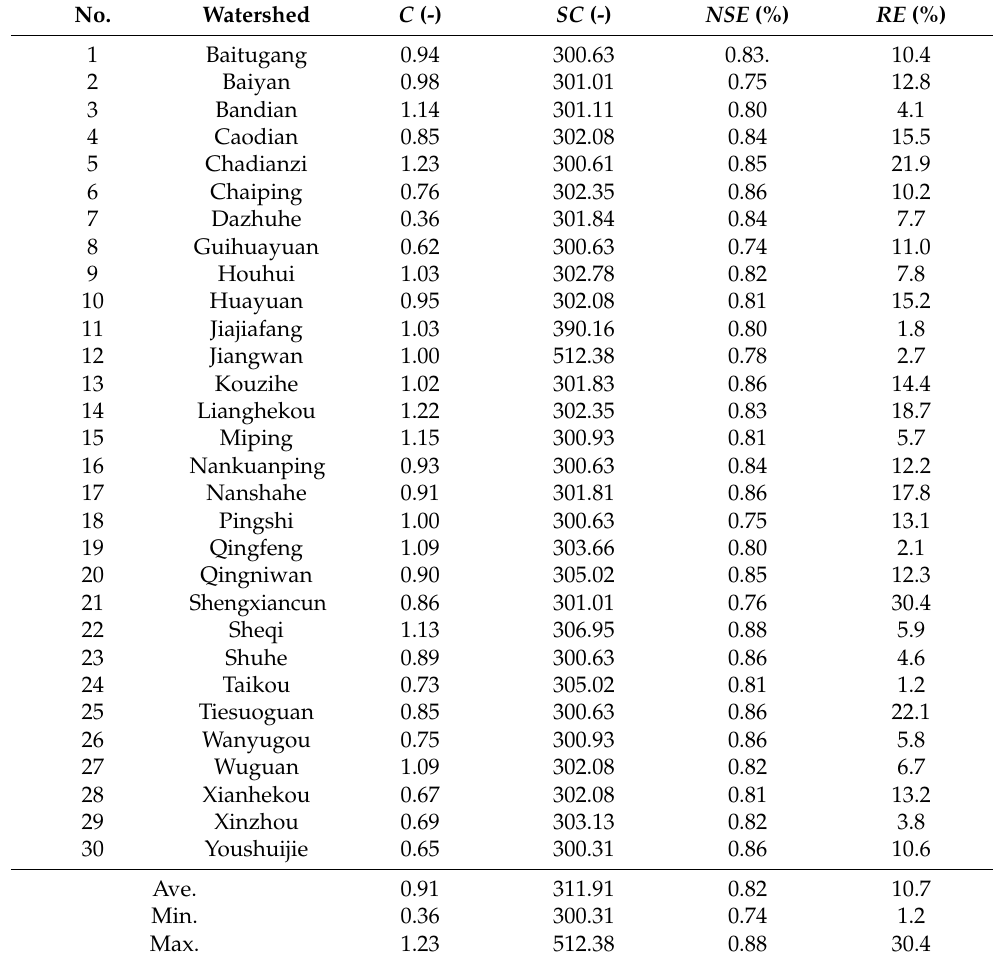
Table 2. Calibrated TPMWB model parameters and performance criteria for the studied